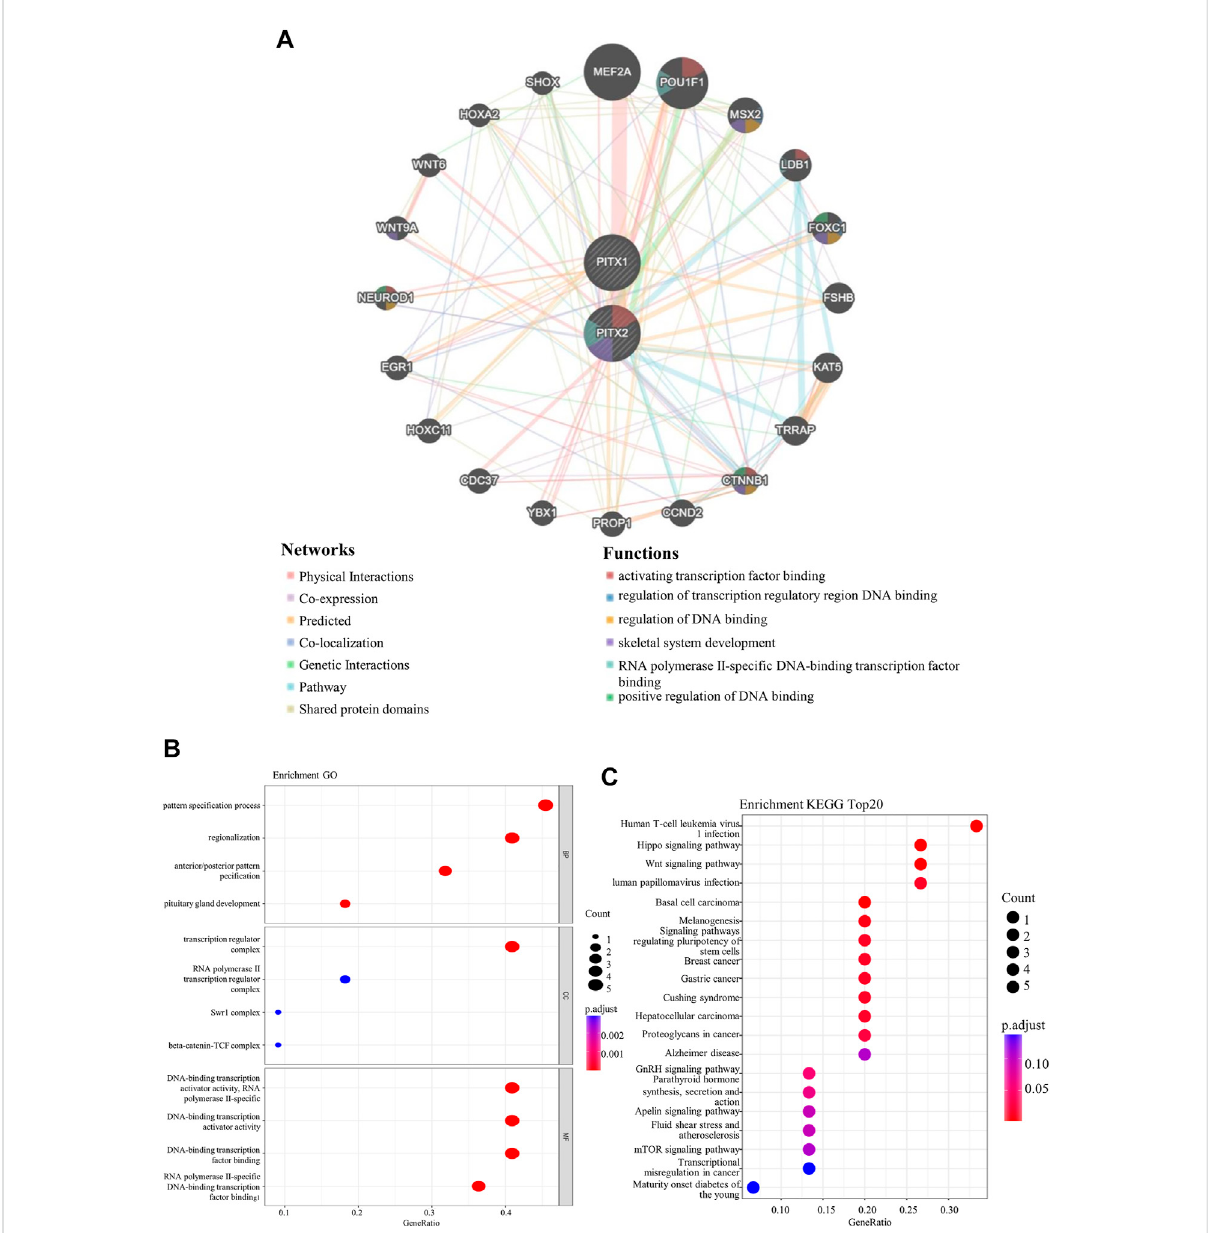
FIGURE 4 The network and functional enrichment analysis of PITX1 and PITX2. (A) The protein-protein interaction (PPI) network for PITX1 and PITX2 (generated using GeneMANIA). The functions of PITX1 , PITX2 , and co-expressed genes were predicted by performing (B) GO and (C) KEGG